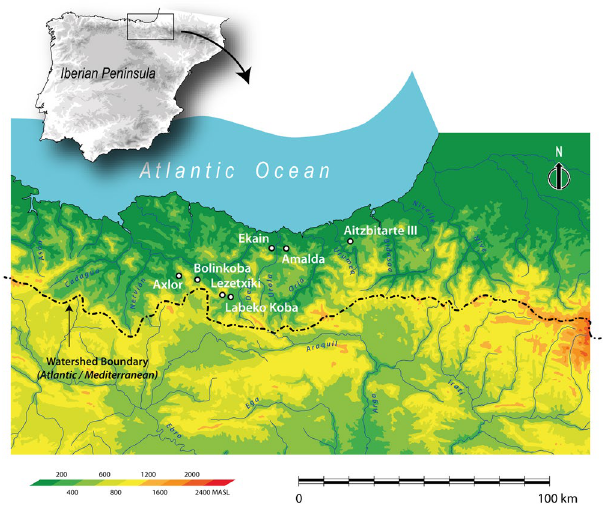
Figure 1. Map of the eastern Cantabrian region, northern Spain, showing the locations of the Bizkaia and Gipuzkoa sites studied. In Bizkaia: Axlor and Bolinkoba. In Gipuzkoa: Lezetxiki, Labeko Koba, Ekain, Amalda and Aitzbitarte